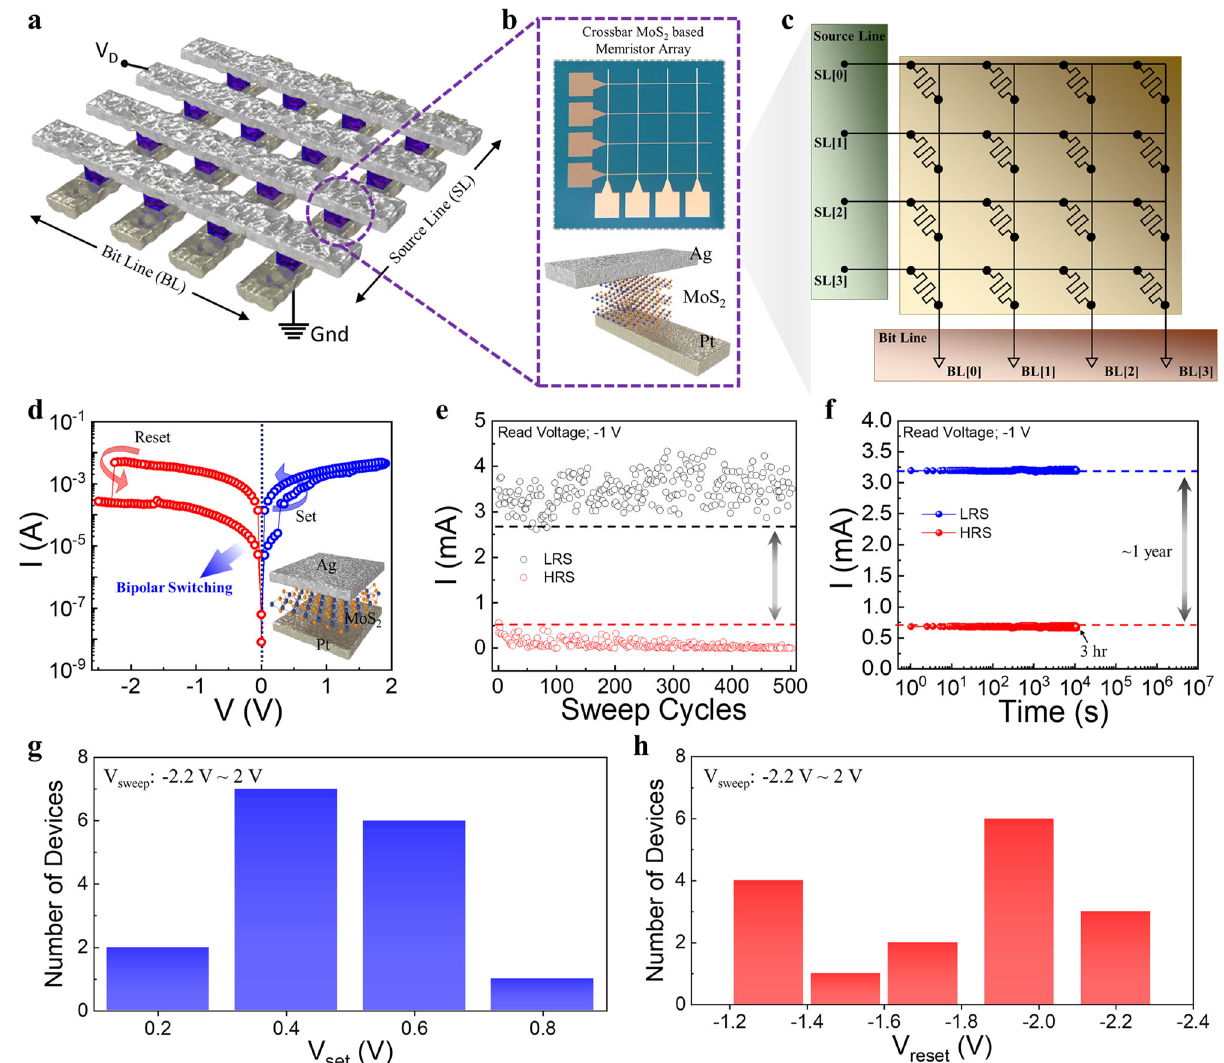
Fig. 2 Electrical measurements of the proposed 4 × 4 crossbar memristor array device. a Architectural schematic layout of the proposed 4 × 4 crossbar memristor array based on large-area direct grown MoS 2 . b A real image of the fabricated 4 × 4 crossbar memristor array along with 3D section view of single memristor device (bottom side). c A schematic illustration of the 4 × 4 crossbar memristor array with demonstration of source line (SL) and bit line (BL). d Bipolar memory switching curve of the MoS 2 memristor devices under voltages between − 2.5 V and 2 V, with an inset showing the schematic layout of the MoS 2 memristor. Memory operations of proposed memristor device in terms of e endurance up to 500 sweep cycles at a read voltage of − 1 V and f retention, measured up to 10 4 s at a read voltage of − 1 V. Electrical memory distribution of the proposed 4 × 4 crossbar memristor array based on large-area direct grown MoS 2 in terms of g V set and h V reset at a sweep voltage range from − 2.5 V to 2 V under ambient